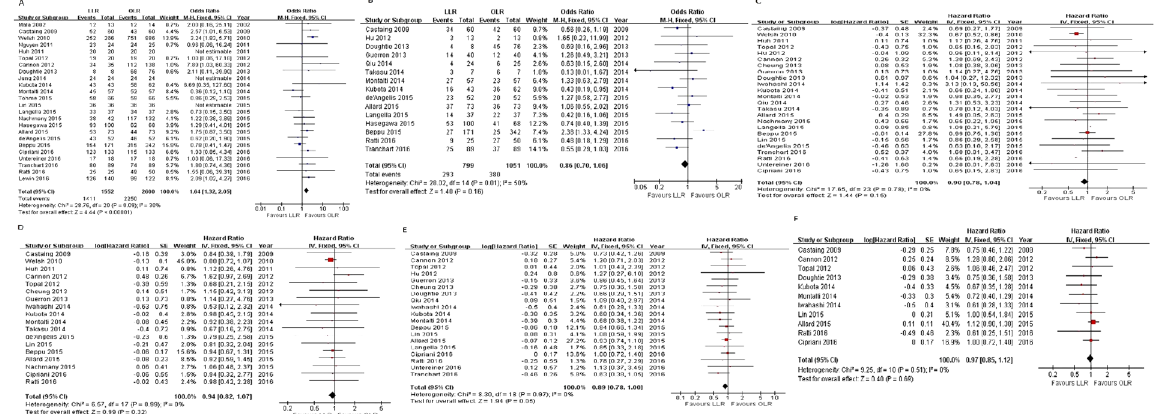
Figure 2. ( A ) Forest plot of negative surgical margin between two groups. ( B ) Forest plot of recurrence between two groups. ( C ). Forest plot of 3-year OS between two groups. ( D ) Forest plot of 5-year OS between two groups. ( E ) Forest plot of 3-year DFS between two groups. ( F ) Forest plot of 5-year DFS between two